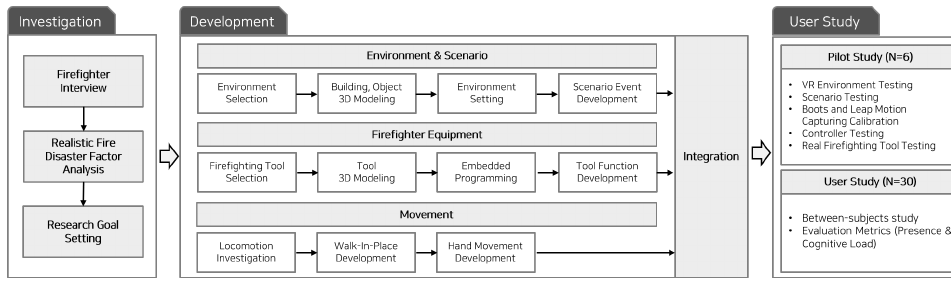
Figure 1. Overall study procedures with three phases: investigation, development, and user